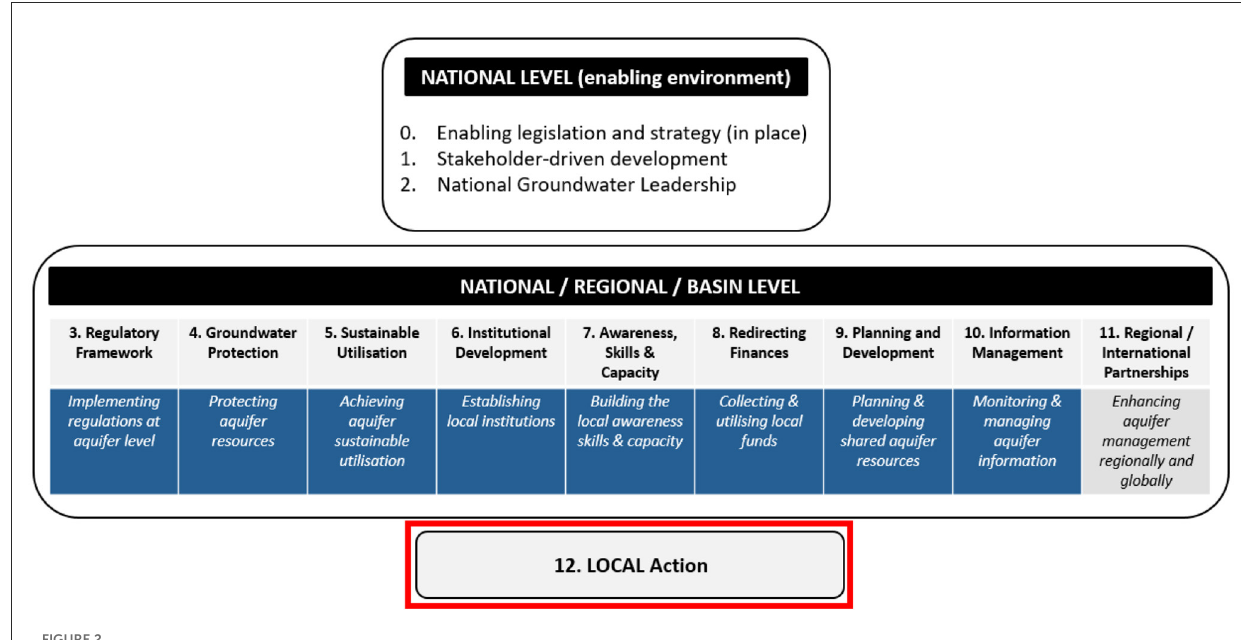
FIGURE2 Groundwater Governance; Source: National Department of Water and Sanitation (2017) highlighting “local